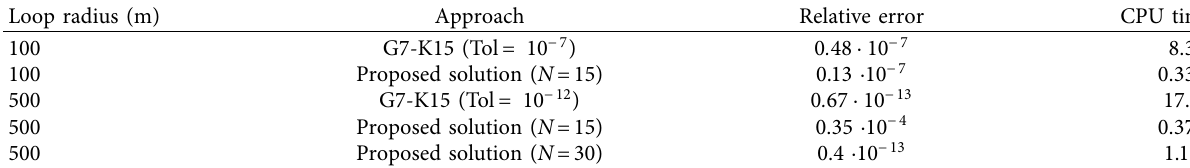
Table 1: CPU time comparisons for the computation of the H